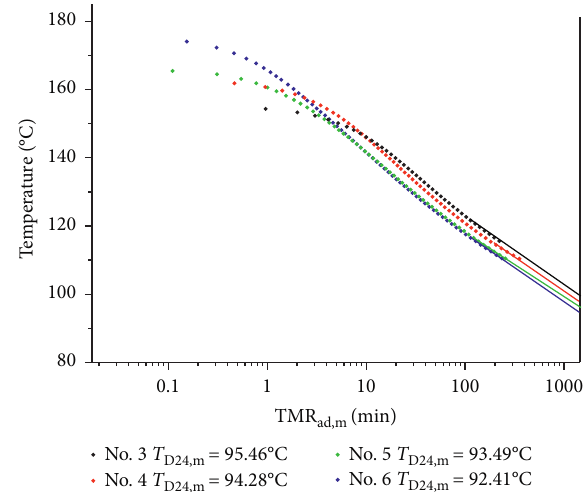
Figure 7: The relationship curve between uncorrected solution temperature and TMR ad,m for 40% DCP.